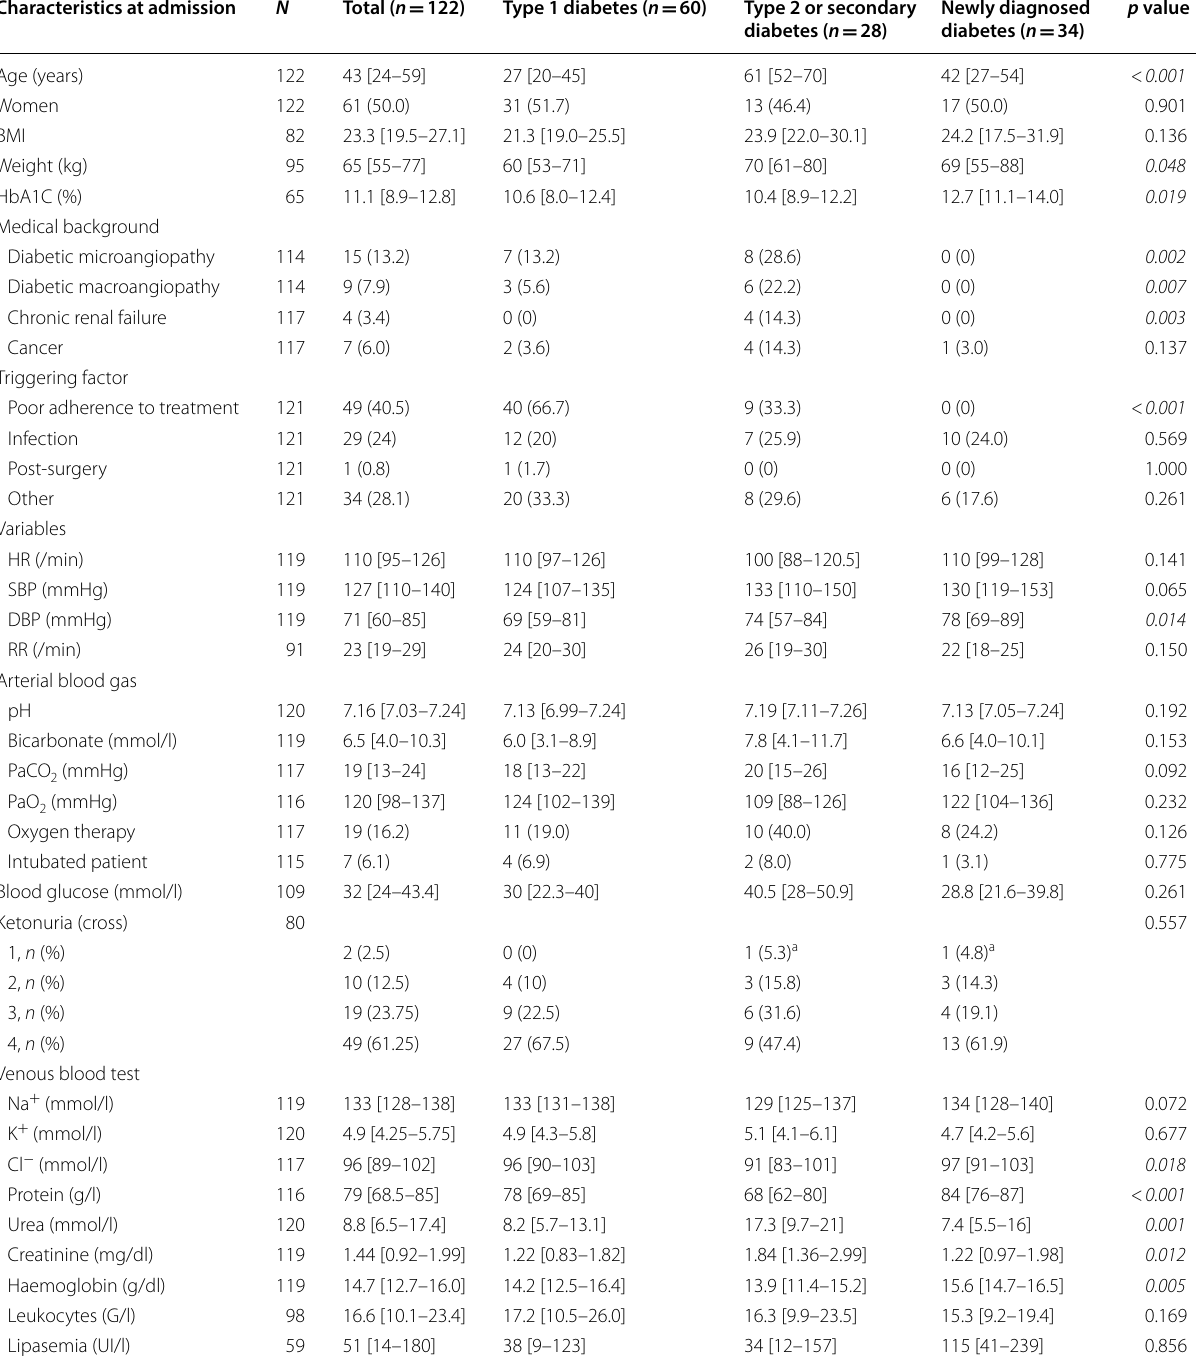
Table 1 Clinical and biological characteristics on admission, according to the type of